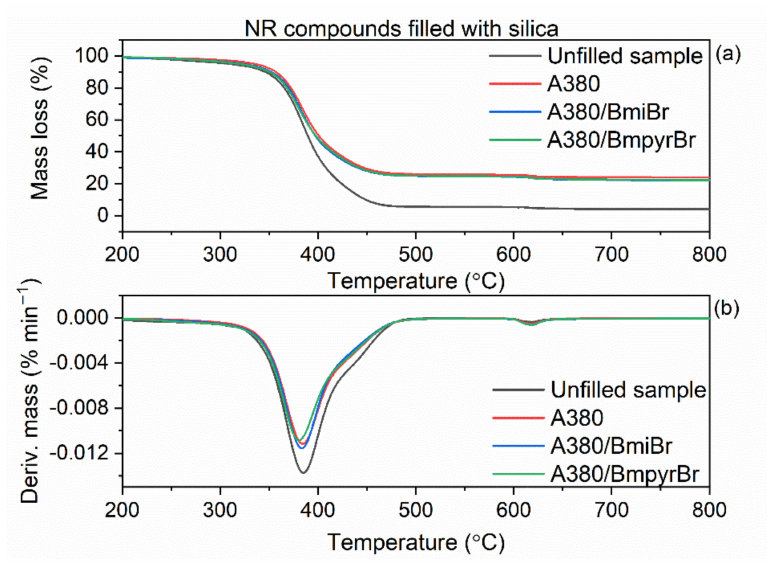
Figure 10. NR vulcanizates filled with silica A380: ( a ) TG curves; ( b ) DTG